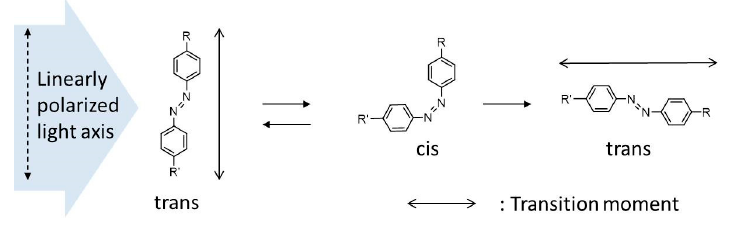
Figure 4. Photoselective orientation of azobenzene molecules via photoisomerization.